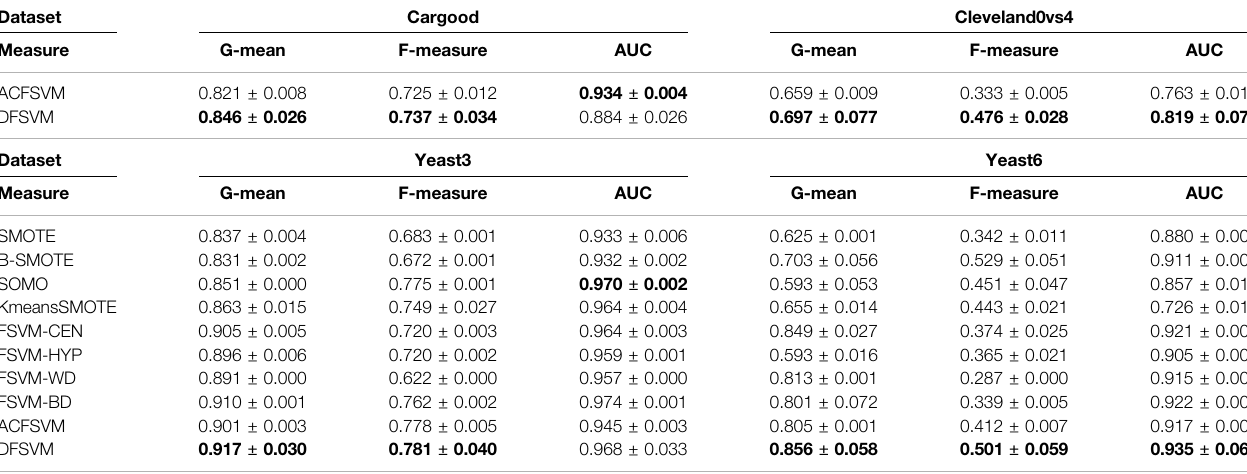
TABLE 2 | ( Continued ) Results of different imbalanced classi fi cation methods on datasets.